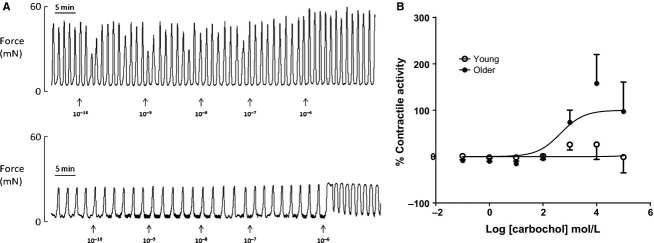
Effects of carbachol on uterine contractile activity. (A) Representative recordings of uterine contractile activity in a YOUNG (top trace) and OLDER (bottom trace) rat dam incubated with accumulative concentrations of Carbachol (range 0.1 nmol/L to 1 μmL/L, units shown are in log mol/L). (B) A dose–response curve to determine the effects of maternal age, YOUNG (n = 4) or OLDER (n = 7) on uterine integral activity to increasing doses of Carbachol (range 0.1 nmol/L to 1 mmol/L, units shown are in log mol/L. Statistical analysis reveals that the dose–response curves were significantly different (P < 0.0002). LogEC50 was significantly shifted by maternal age, YOUNG logEC50 = 6.73, OLDER logEC50 = 2.66.